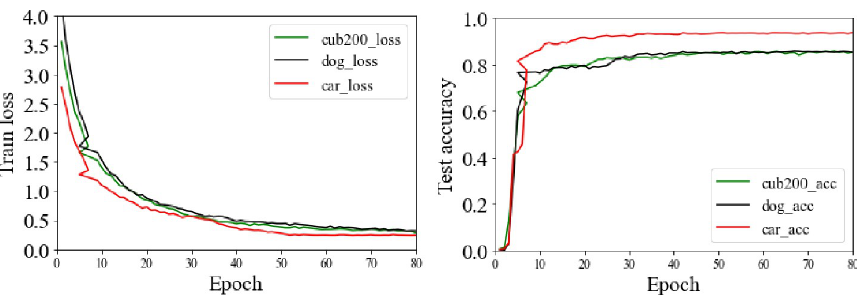
Fig 9. The test accuracy curve and train loss curve on CUB-200-2011, Stanford Cars and Stanford Dogs datasets.